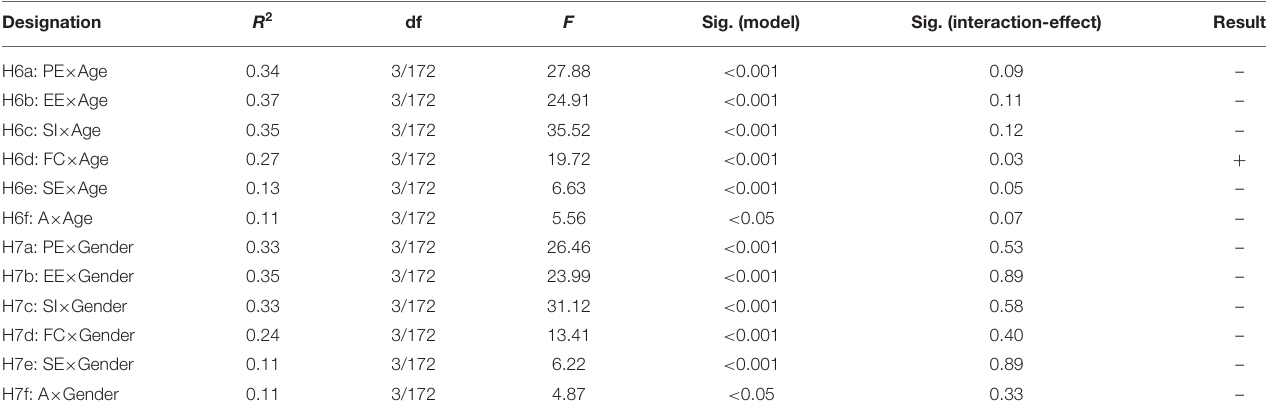
TABLE 9 | Influence of moderators on attitude to